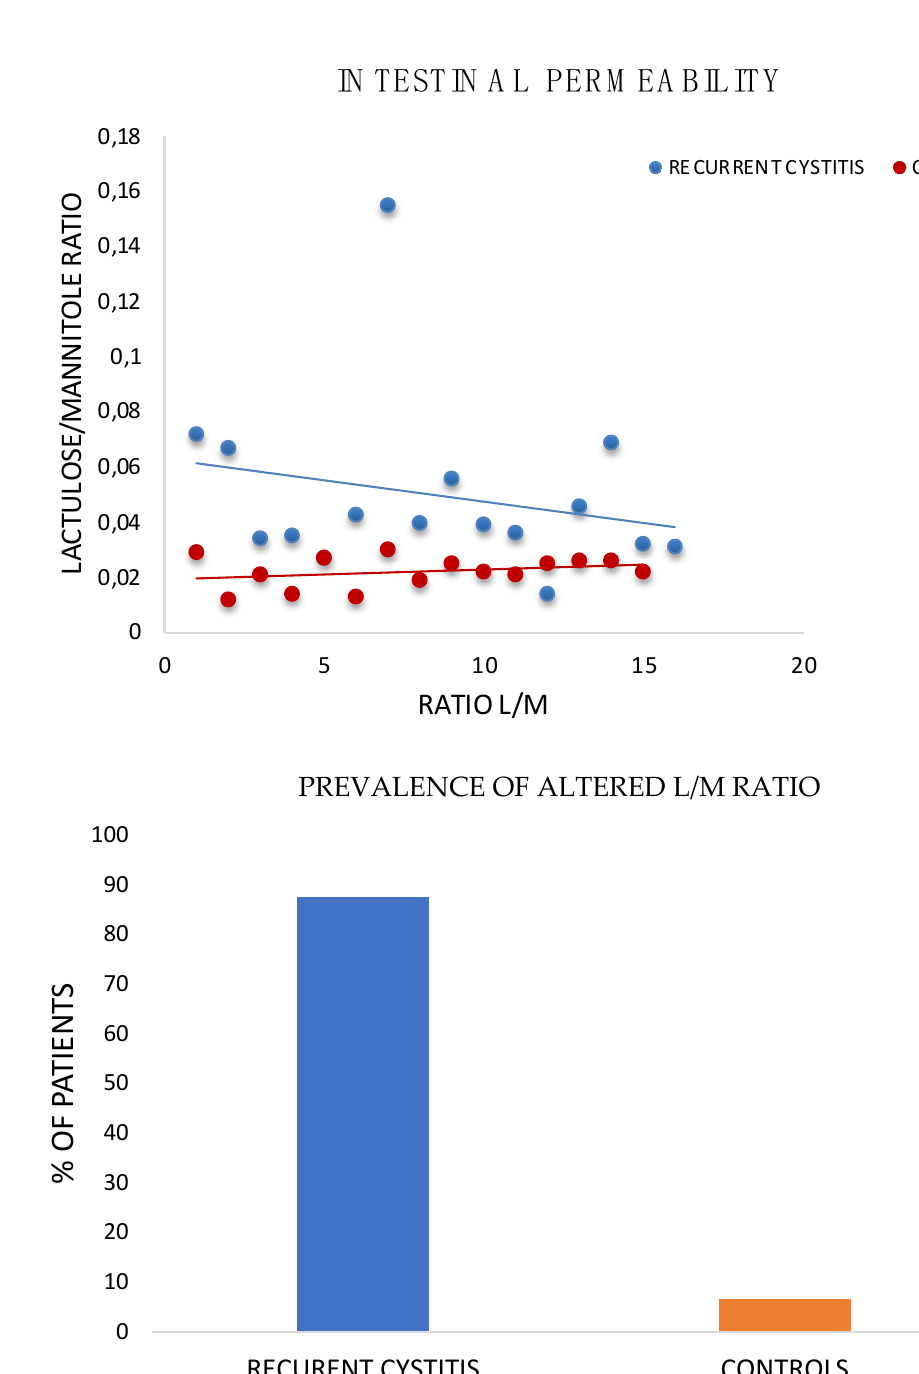
Figure 3. Intestinal permeability modification in patients with RC (cohort I). ( A ) Intestinal permeability. Patients affected by recurrent cystitis showed a statistically significant increase in intestinal permeability, measured as L/M ratio (lactulose/mannitol) with an average urinary ratio of lactulose/mannitol equal to 0.050 compared to 0.02 of controls. ( p < 0.05). ( B ) Prevalence of altered L/M ratio. Of patients affected by recurrent cystitis, 88% displayed an altered L/M ratio compared to